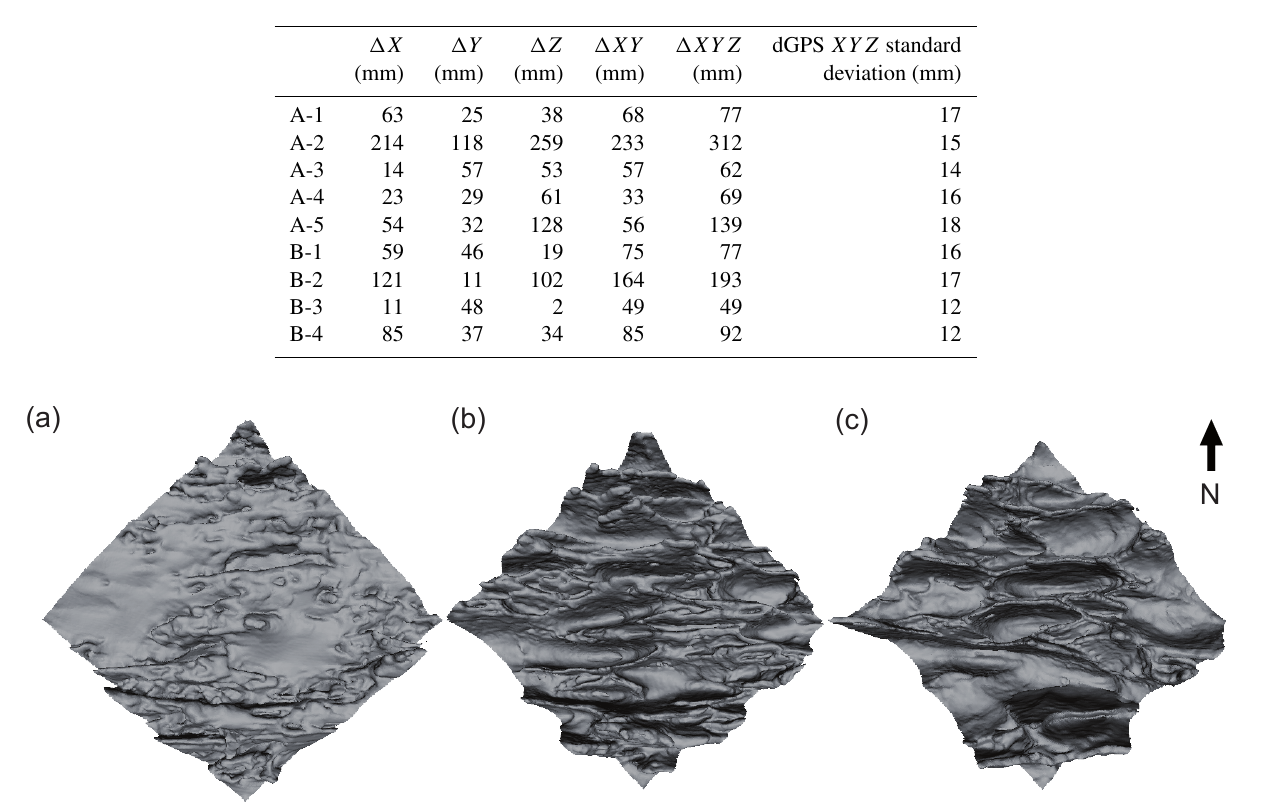
Figure 3. Shaded DSM meshes of N–S-orientated DSMs for the 1.5m × 1.5m glacier site B on (a) 12 December 2013, (b) 20 December 2013 and (c) 3 January 2013 obtained using the